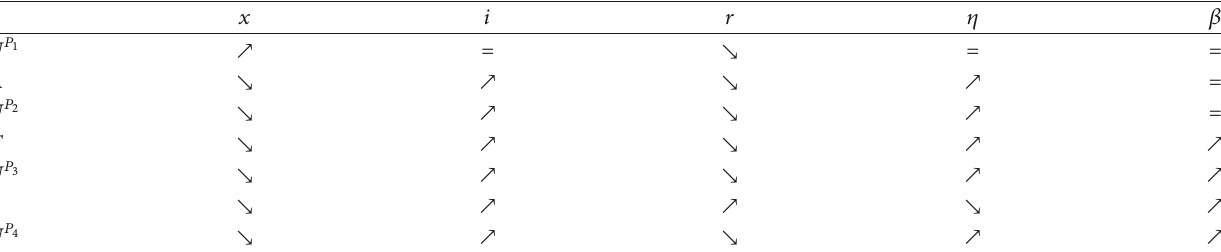
Table 3: The premiums with respect to the various parameters.